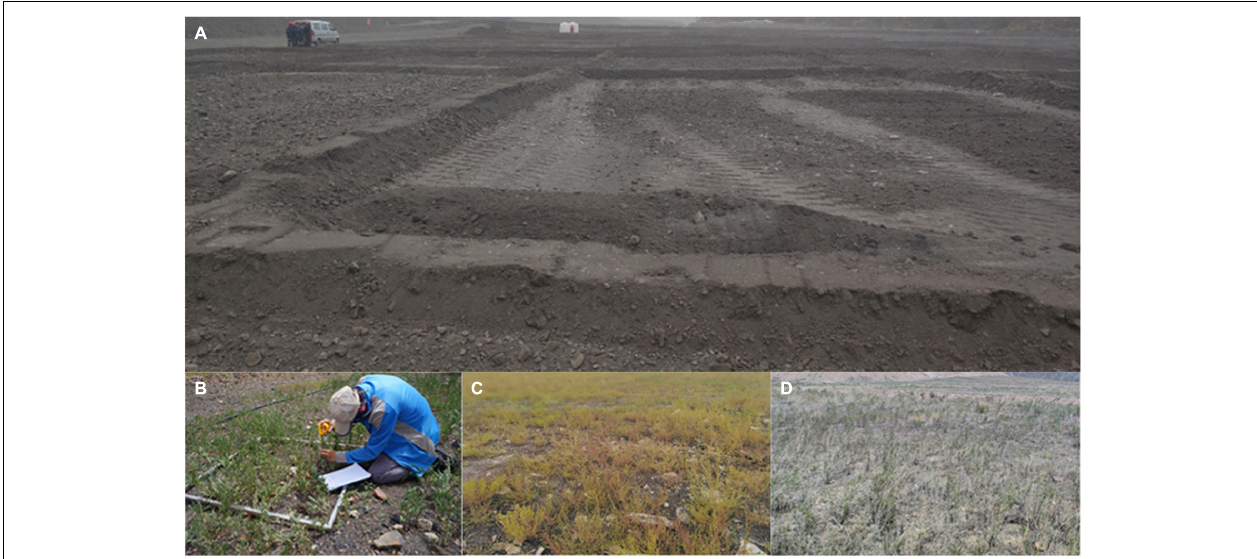
FIGURE 1 | Photographs illustrating quadrats of bare land that were re-vegetated by different plant species. The images were taken by Zihao Li and Dachuan Mao. (A) Land before re-vegetation (2018); (B–D) after re-vegetation with A. laxmannii , H. arachnoideus , and A. desertorum, respectively (2020). TABLE 1 | Information for plant communities in each quadrat. Plant